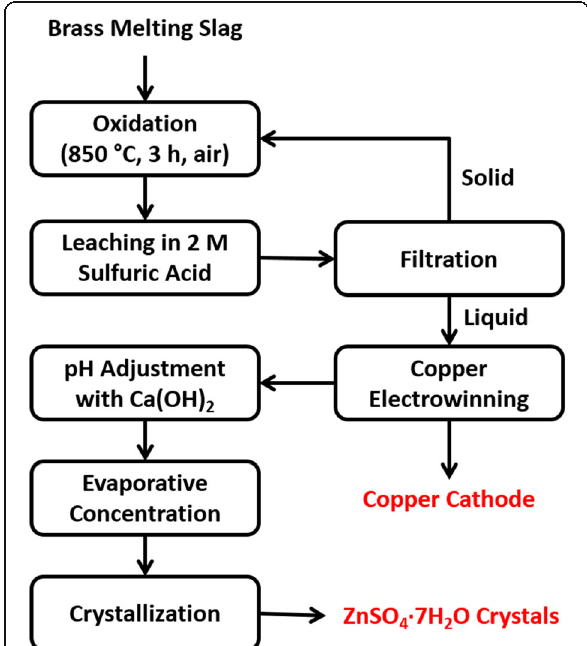
Fig. 5 Effect of oxidation temperature on leaching efficiency of brass slag (Leaching in sulfuric acid for 4 h at 50 °C). The leaching efficiency of as-received slag before oxidation was 34%